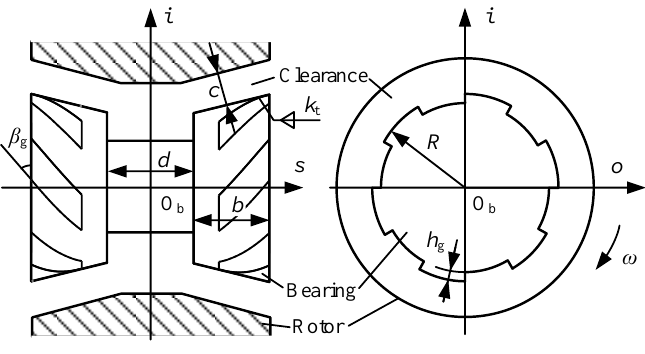
Figure 2. The configuration of the gas-dynamic bearing.